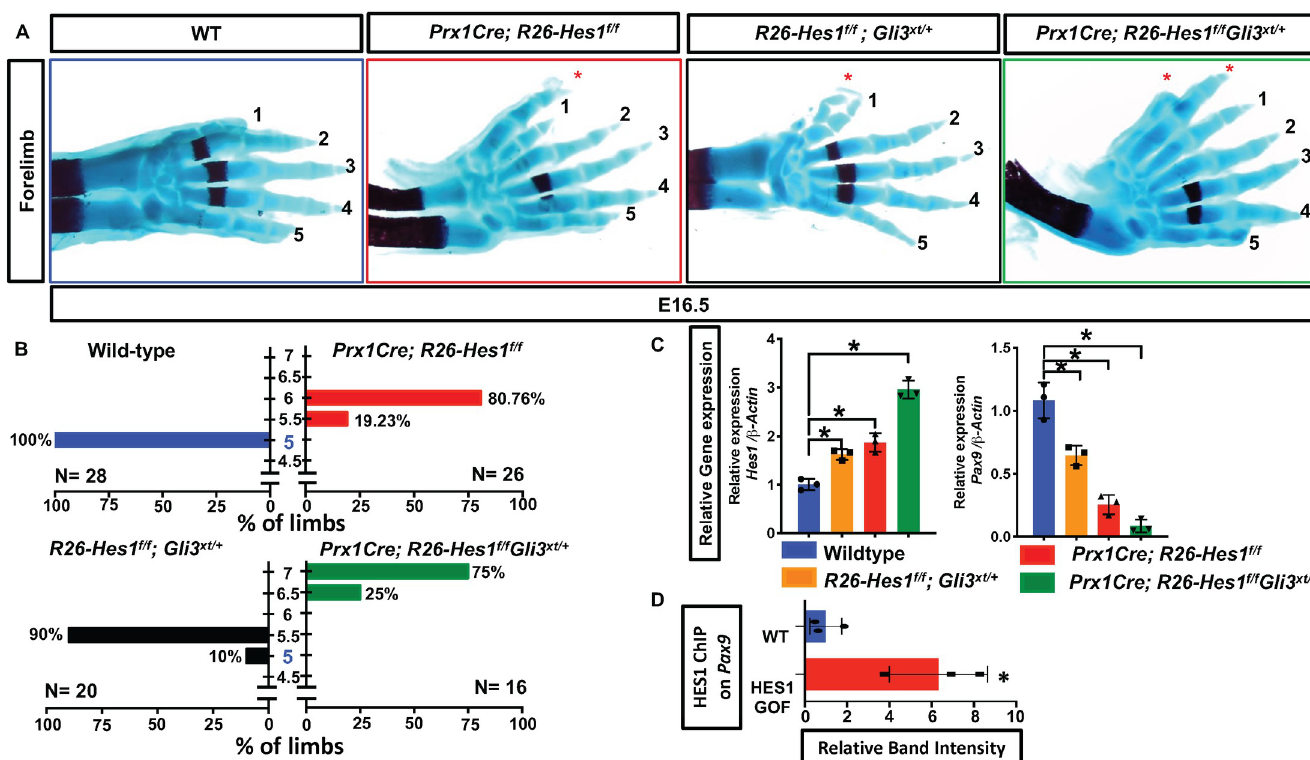
Fig 7. HES1 and SHH/GLI3 signaling cooperatively regulate digit number. (A) Alcian Blue/Alizarin Red staining of WT, Prx1Cre; R26-Hes1 f/f (HES1 GOF), R26-Hes1 f/f ; Gli3 xt/+ (GLI3 HET), and Prx1Cre; R26-Hes1 f/f ; Gli3 xt/+ (HES1 GOF/GLI3 HET) double mutant forelimbs. Red asterisks indicate extra digits (B) Quantification of digit numbers for WT (N = 26), HES1 GOF (N = 28), GLI3 HET (N = 20), and HES1 GOF/GLI3 HET (N = 16) forelimbs ( χ 2 test) (p-value < 0.0001).). Y axis represents the number of digits whereas the x-asix represents the percent of the forelimbs. Intervals of 0.5 represent syndactylous digits. (C) qPCR for Hes1 and Pax9 on RNA from E11.5 WT, Prx1Cre; R26-Hes1 f/f (HES1 GOF), R26-Hes1 f/f ; Gli3 xt/+ (GLI3 HET), and Prx1Cre; R26-Hes1 f/f ; Gli3 xt/+ (HES1 GOF/GLI3 HET) double mutant limb buds (N = 3). Each data point represents separate animals. Asterisks indicate significance with a p-value < 0.05 (One-way ANOVA). (D) Densitometry measurements of ChIP PCR amplifications from the chromatin containing an E-Box within the Pax9 promoter of WT and HES1 GOF limb buds (N = 3; p-value < 0.05; Student’s